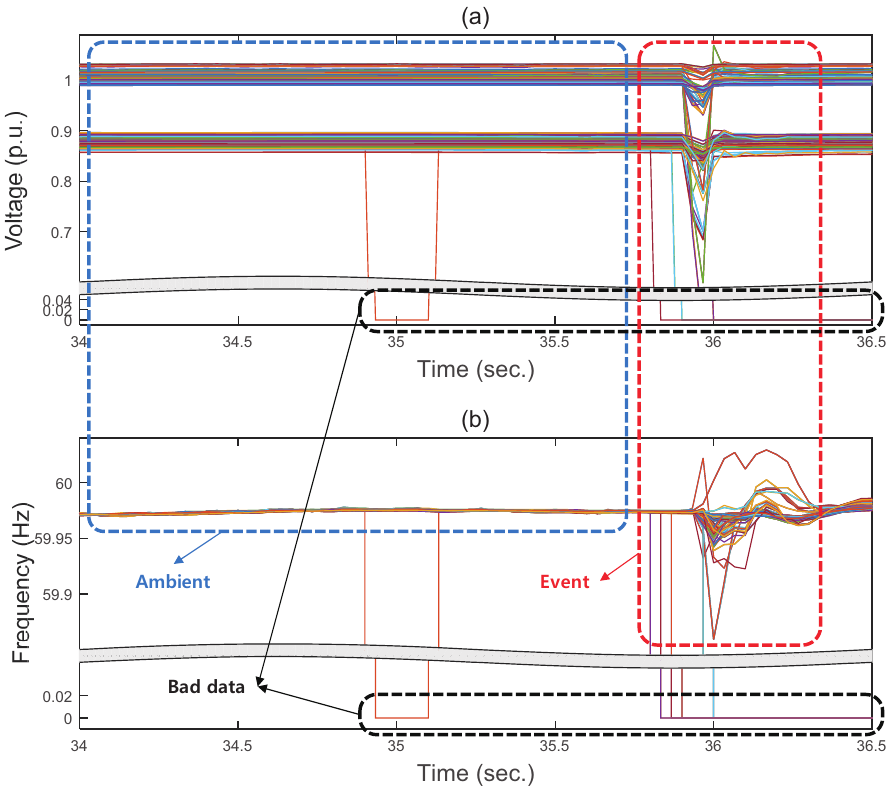
Figure 1. Phasor measurement unit (PMU) signals in real world. ( a ) Voltage; ( b )